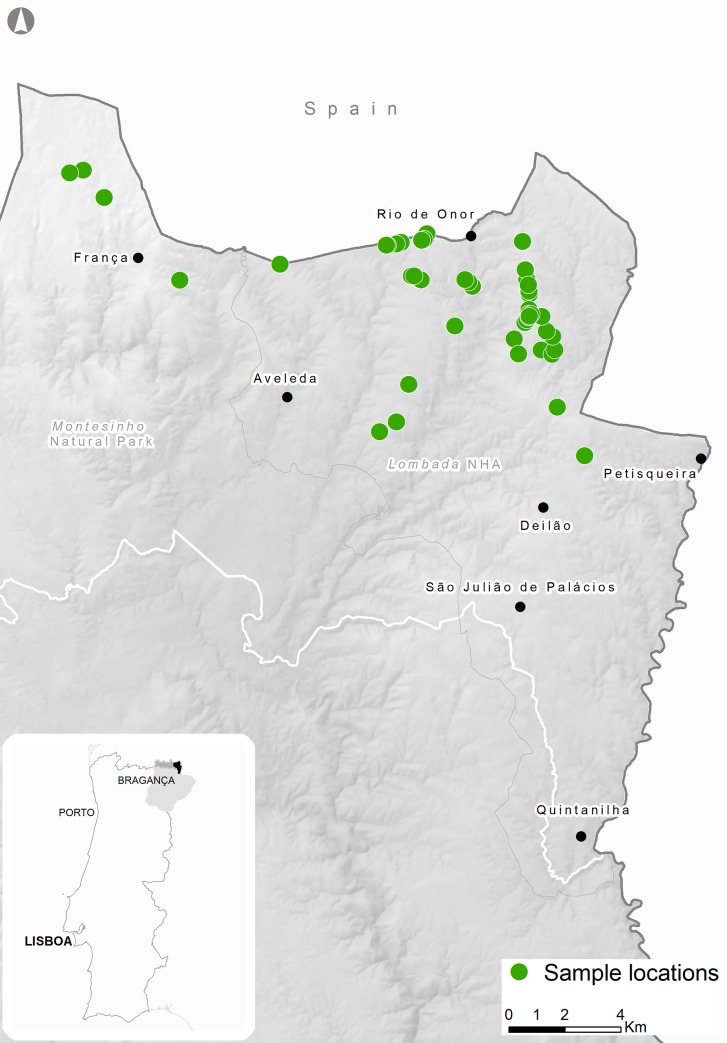
Location of the study area in Portugal.The green circles correspond to the location of Iberian wolf scats used in diet analysis (Montesinho Natural Park).